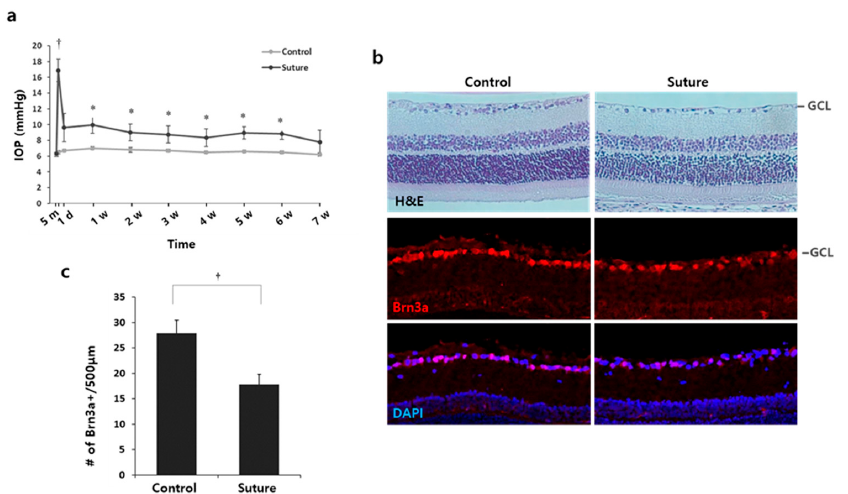
Figure 1. Circumlimbal suture induces chronic OHT and RGC death in rats. ( a ) IOP was measured before surgery, 5 min after suture, and once a week thereafter for 7 weeks. Chronic ocular hyper- tension was achieved in eyes that received the circumlimbal suture after the IOP spike. * p < 0.05, † p < 0.01; n = 8 for each group. ( b ) The retinas from the control or sutured eyes were stained with H&E or the Brn3a antibody specific to RGC. Cell density in the GCL and Brn3a + cells was reduced in the sutured eyes compared to the controls. ( c ) Brn3a positive cells were quantified. In the sutured eyes, the number of Brn3a + cells decreased by 25%. † p < 0.01, Mean ± standard deviation; n = 4 for each group. GCL: Ganglion cell layer, H&E: hematoxylin and eosin, IOP: intraocular pressure, OHT: ocular hypertension, RGCs: retinal ganglion cells.